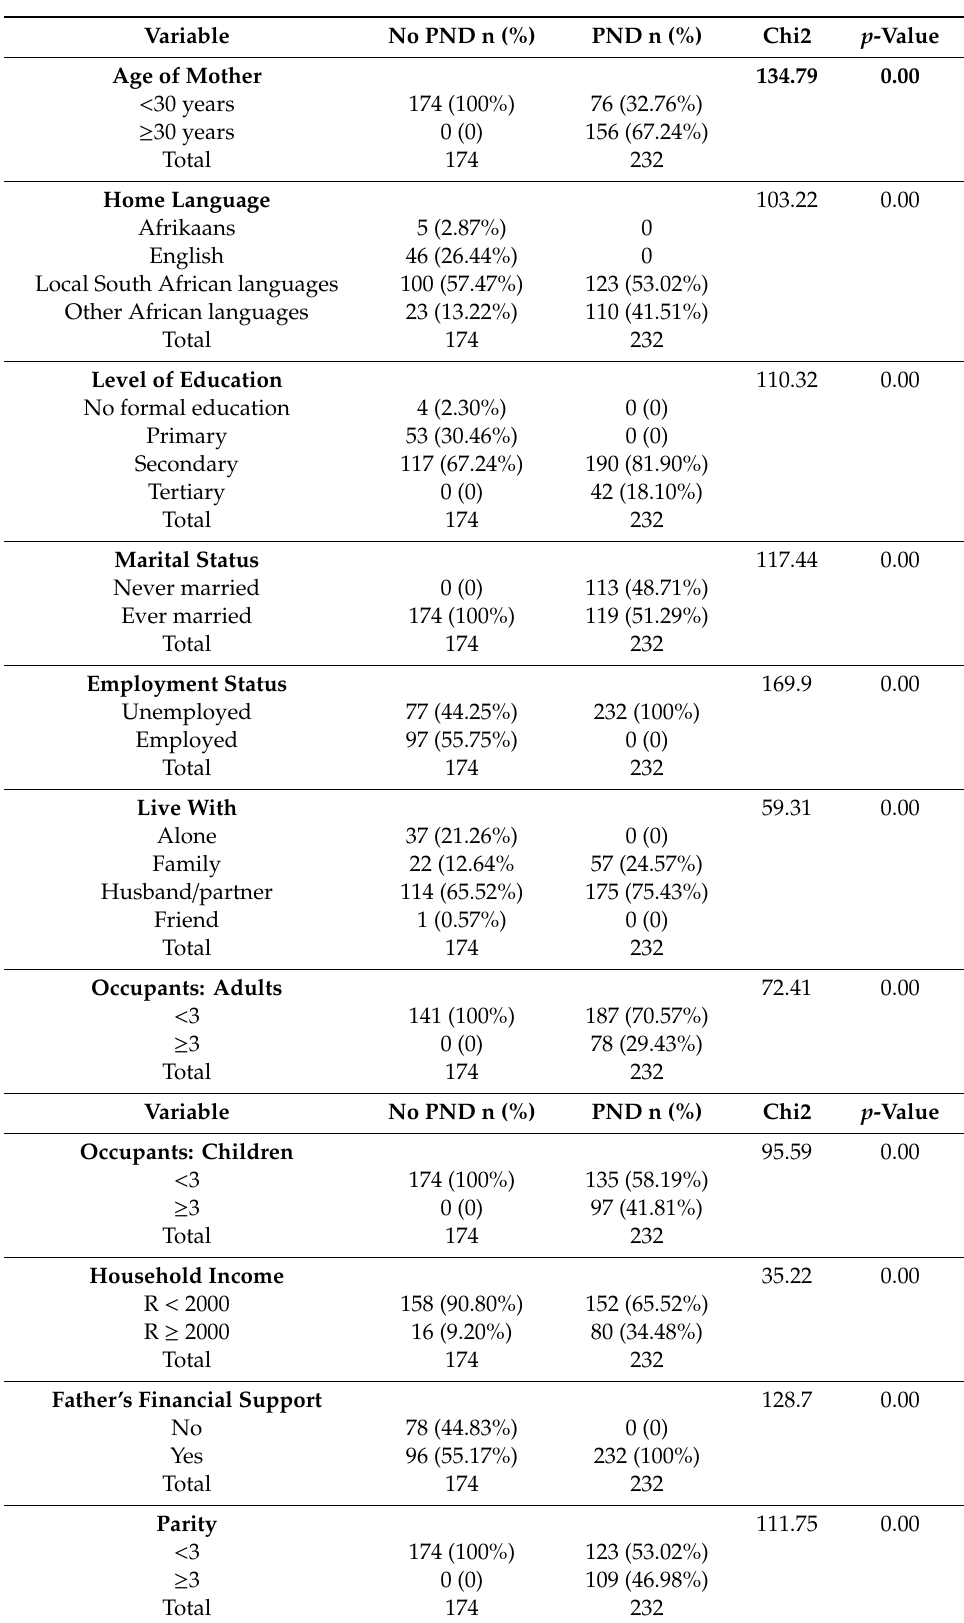
Table 3. Pearson chi-square comparison for participants with PND and those